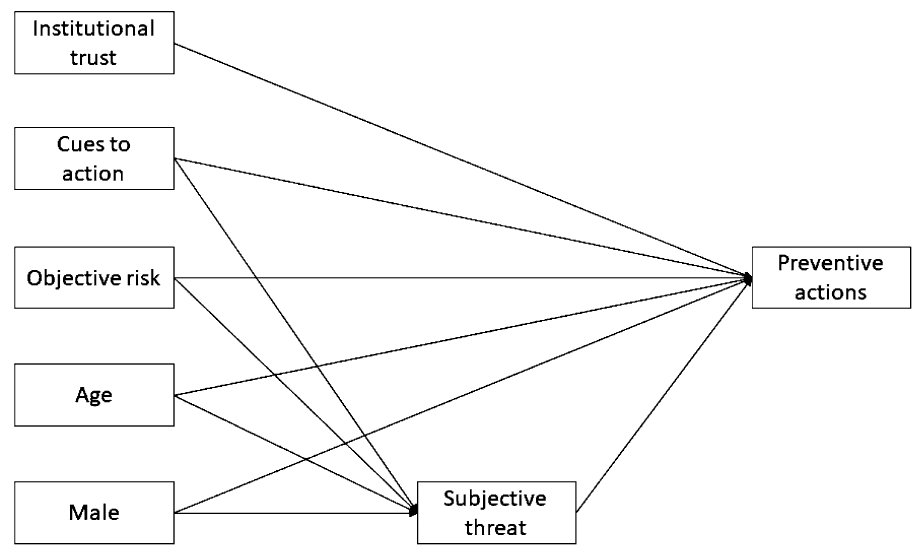
Figure 2. Baseline model. This model does not include moderators.